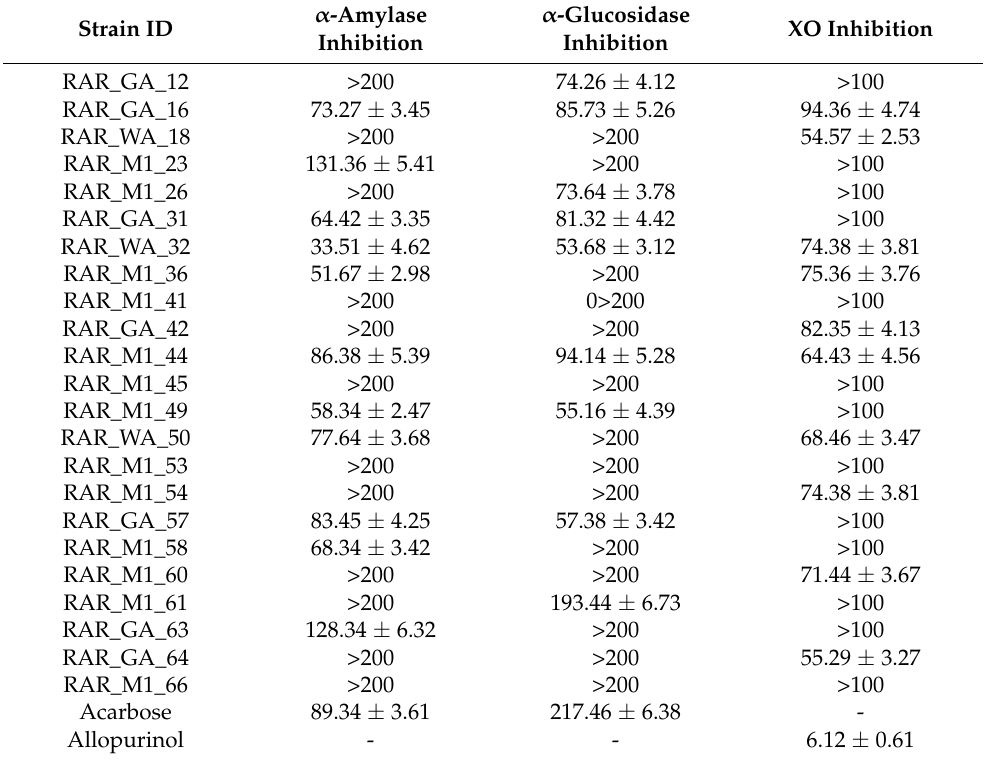
Table 4. α -Amylase, α -glucosidase, and xanthine oxidase inhibitory activities of the bacterial extracts (IC 50 , µ g/mL).